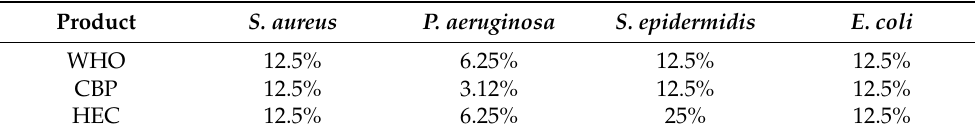
Table 5. MIC obtained for the formulation with hydroxyethylcellulose (HEC), for the formulation with carbopol (CBP) and for the formulation 1—WHO against the selected strains Staphylococcus aureus (ATCC 6538), Pseudomonas aeruginosa (ATCC 9027), Staphylococcus epidermidis (ATCC 12228), and Escherichia coli (ATCC 87394) (n = 2; r =